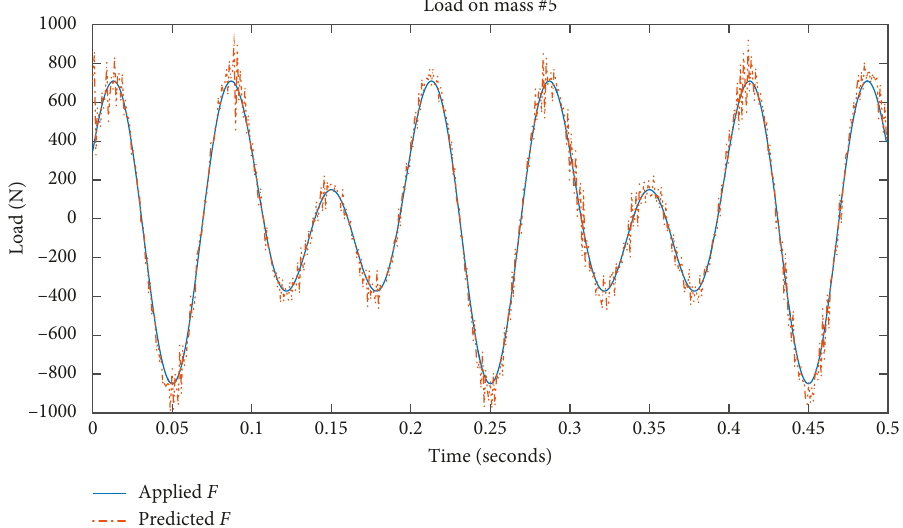
Figure 10: Applied and reconstructed load at mass 5 with measurement errors.